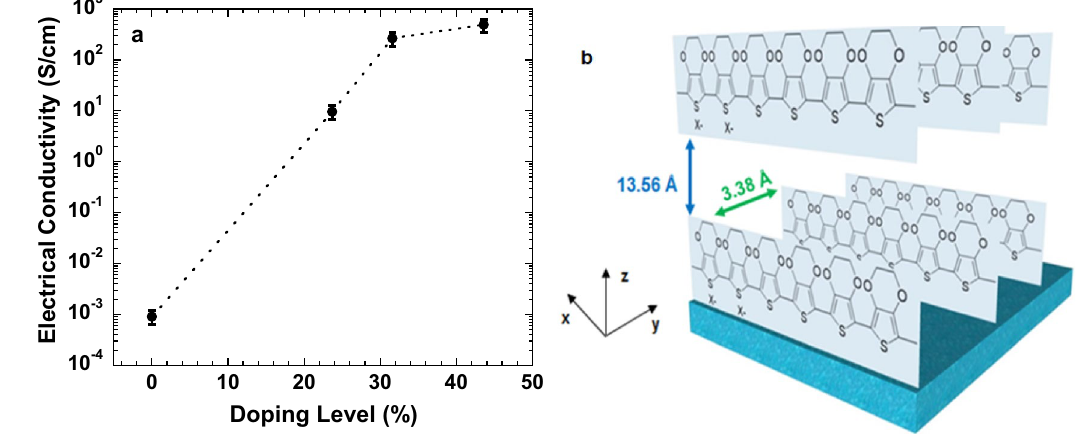
Figure 2. ( a ) The electrical conductivities of the PEDOT:Tos thin films with different doping levels of Tos; and ( b ) the proposed molecular packing of the PEDOT:Toss thin film (at the doping level of